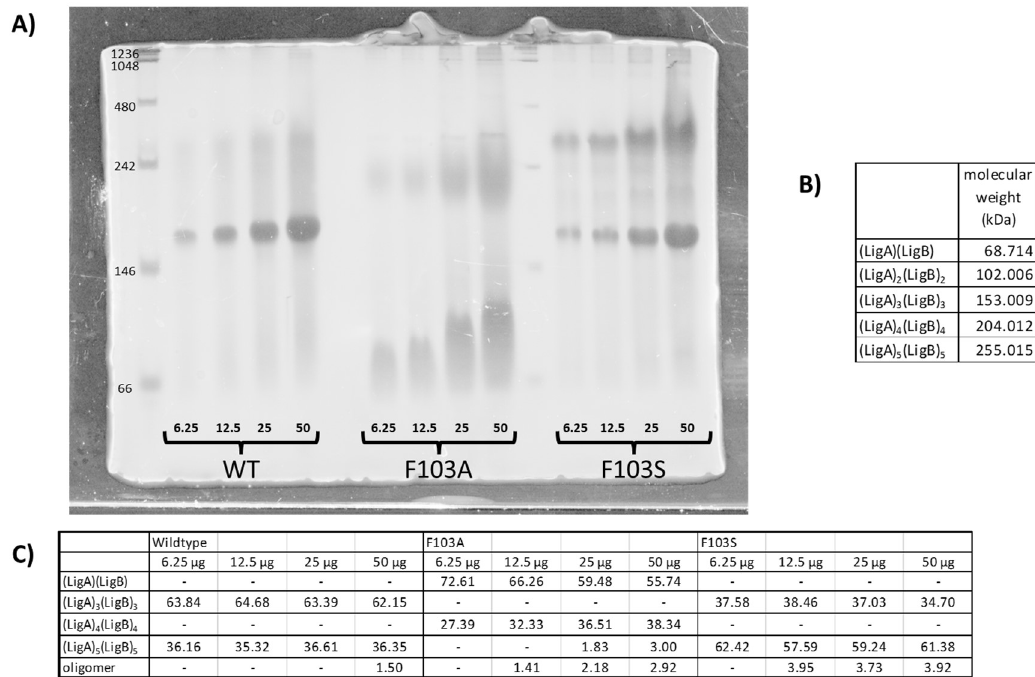
Figure 3. Native gel analysis of wild-type LigAB, F103A, and F103S mutants. ( A ) A 10% Native Polyacrylamide gel of wild-type, F103A, and F103S stained with Coomasie Blue. The bands show the different oligomerization states of the mutants compared to the wild-type, where protein samples are varied from 6.25 to 50 ug of protein loaded per lane. ( B ) The calculated molecular weights of the oligomerization states as seen on the Native Polyacrylamide gel. ( C ) The percentages of the mutations in the various dimerization states of LigAB and the mutants as determined by ImageQuant.